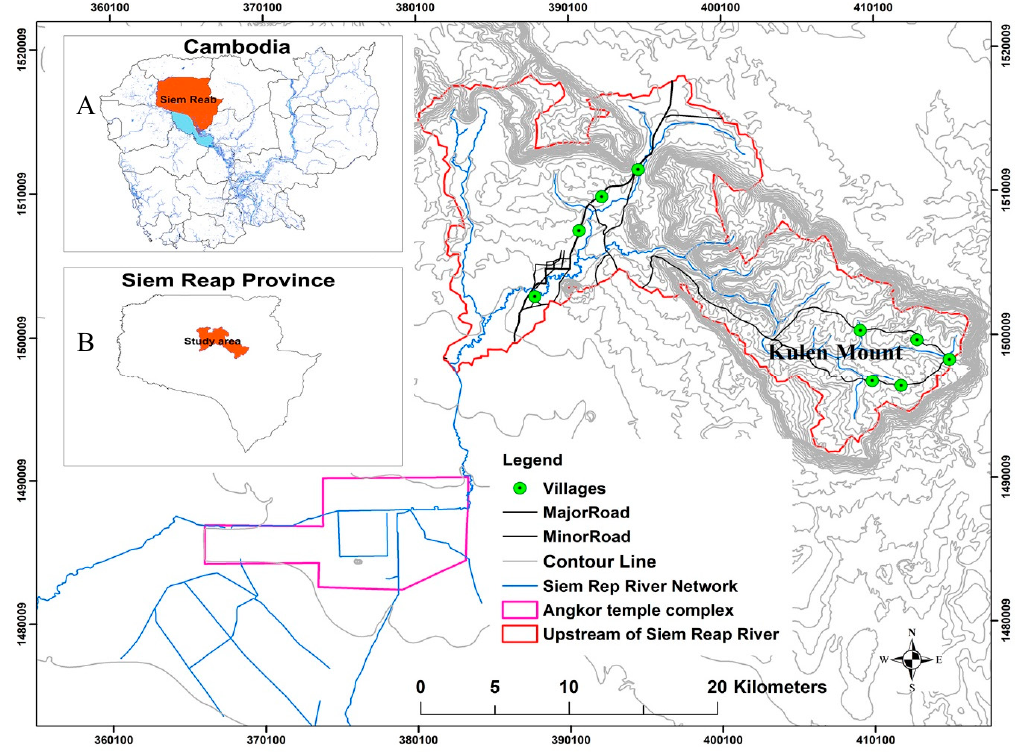
Figure 1. Map of the study area (WGS 84 Zone 48 N). The province of Siem Reap is located in the north of Cambodia ( A ), and the study area is in the central part of the province ( B ). The study catchment is the primary water source for the network of canals that supply the Angkor complex and the Siem Reap